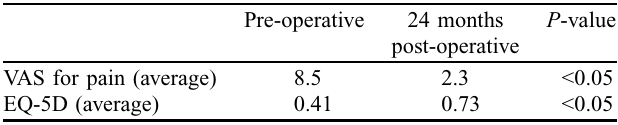
Table 6. Comparison between pre-operative secondary outcome measures (visual analogue scales and quality of life) and 24 months post-operative.